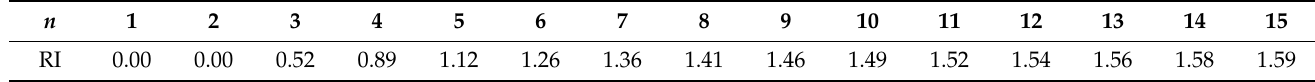
Table 3. Random average consistency indexes.